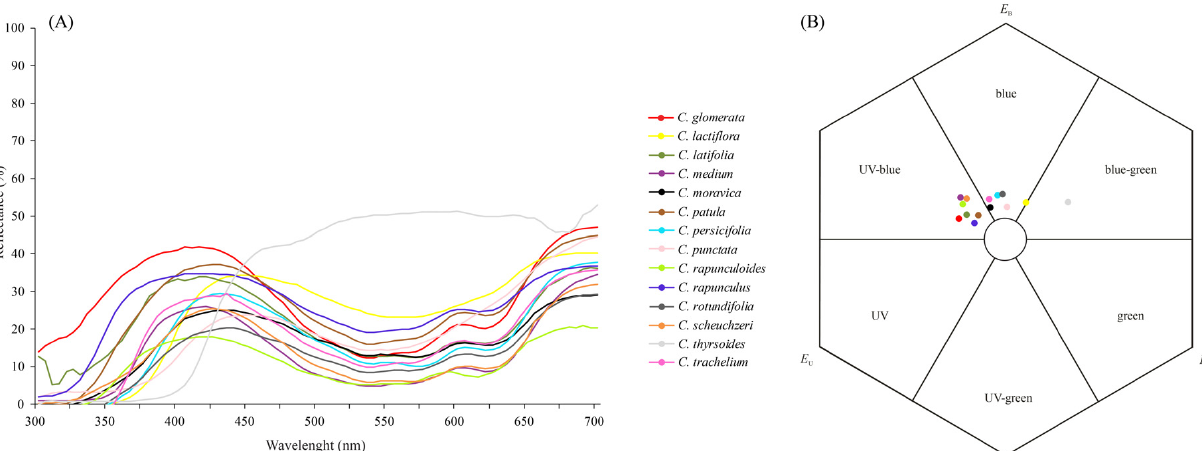
Figure 1. Mean spectral reflectance curves of 14 Campanula species ( A ) and the corresponding color loci plotted in a hexagon color space against a standard green leaf ( B ). E U , E B , and E G represent the excitation of the UV, blue, and green bee receptor, respectively. The pairwise distances between the color loci and between each color locus and the uncolored point (center of the hexagon) are given in the online Supplementary Material (Table